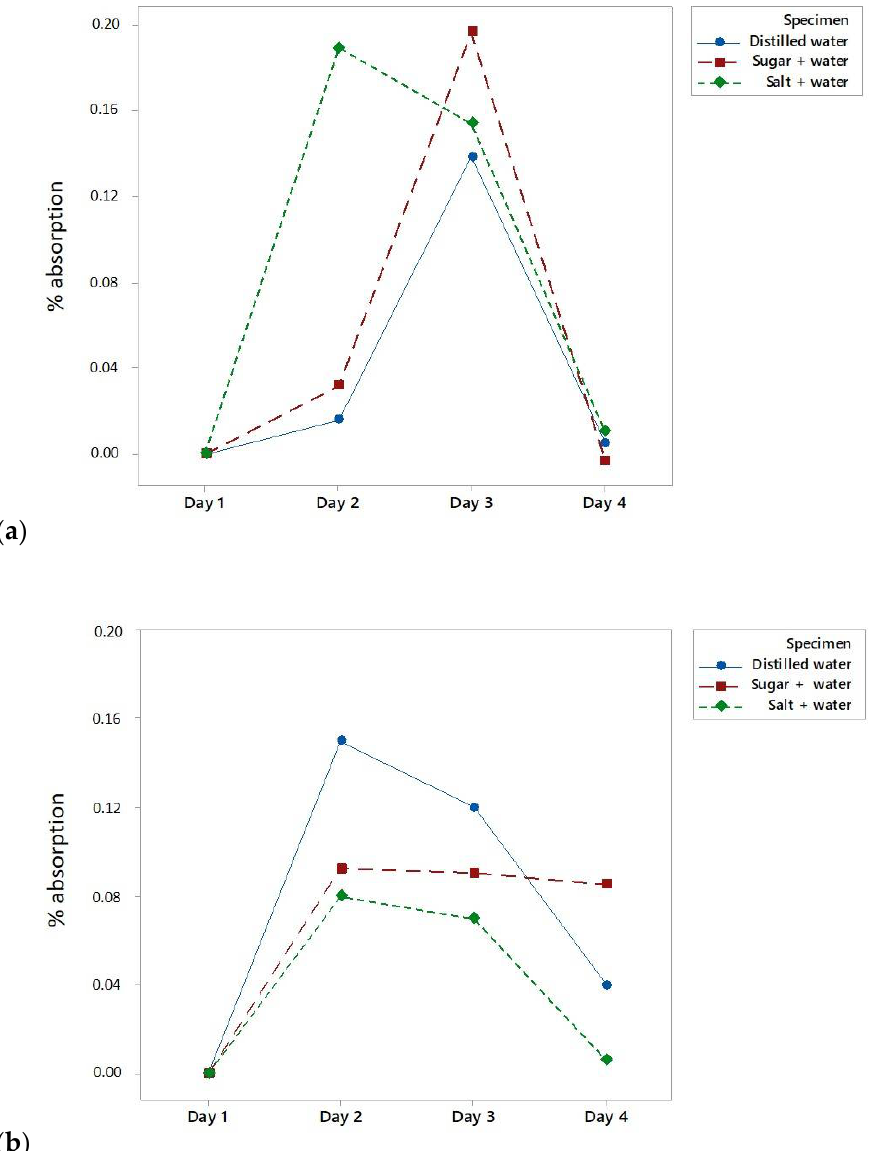
Figure 3. Water absorption for the immersed specimens: ( a ) PLA values; ( b ) PETG values. It was deduced from previous graphs that the highest amount of liquid for all solutions happened in the very first days, probably because the liquid rapidly flowed inside